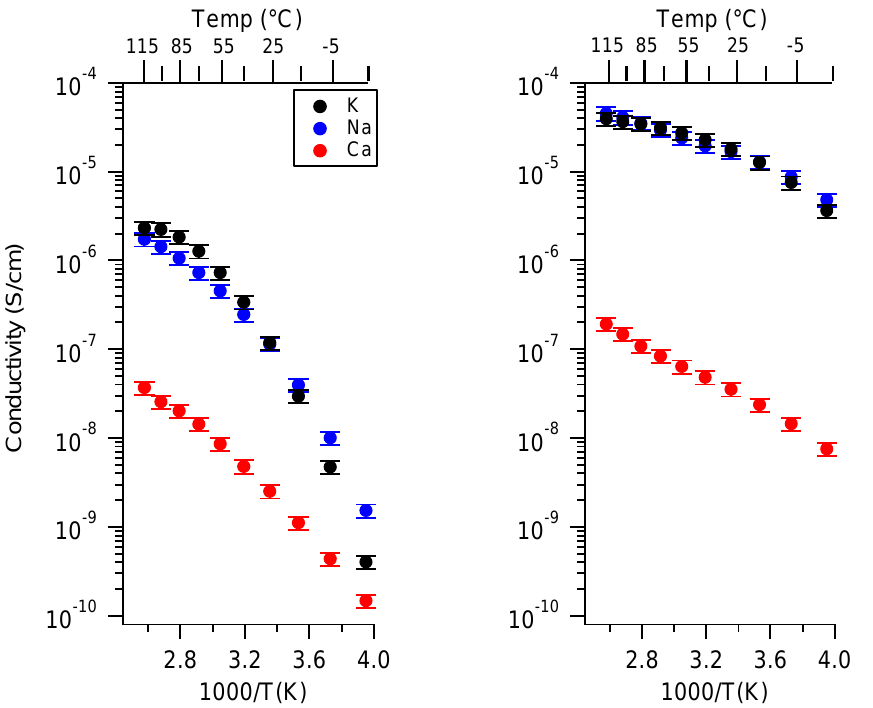
Figure 3. Conductivity as a function of cation for PEGDMA1000_low_SSM (left) and PTHFDA1000_low_STFSIM (right) SIPEs swelled with DEG. Temperatures ranged from − 20 °C to 115 °C.